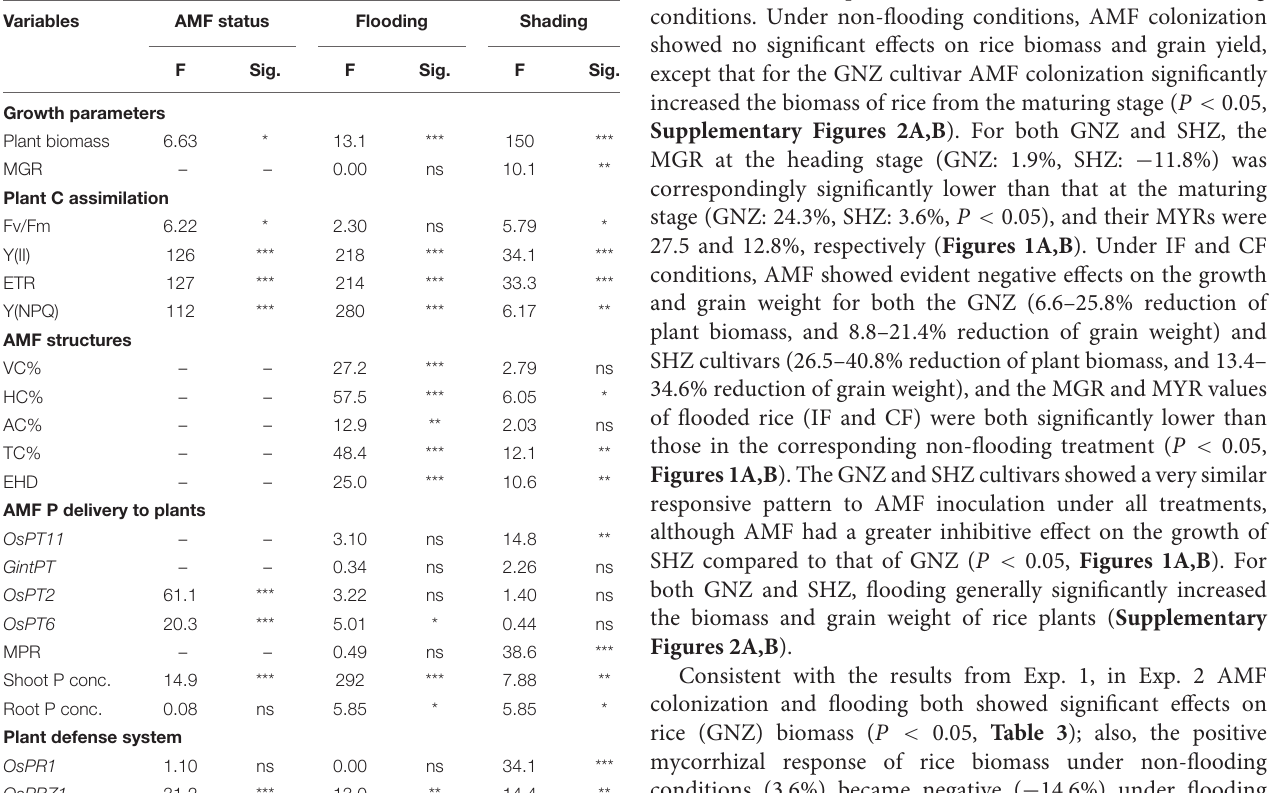
TABLE 3 | Analysis of parameter estimates from generalized linear models: effects of AMF status, flooding, and shading treatments on tested plants and AMF